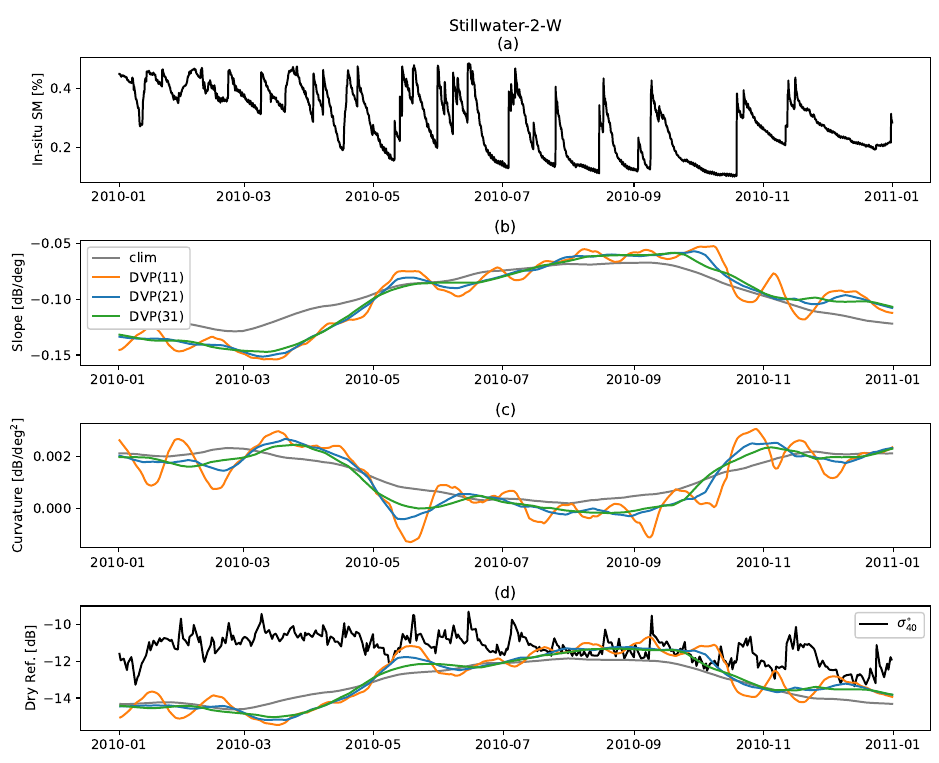
Figure 9. ( a – d ) The influence of the kernel half-width (in days 11: orange, 21: blue or 31: green) on the dynamic vegetation parameters and estimated dry reference at Stillwater, Oklahoma, in